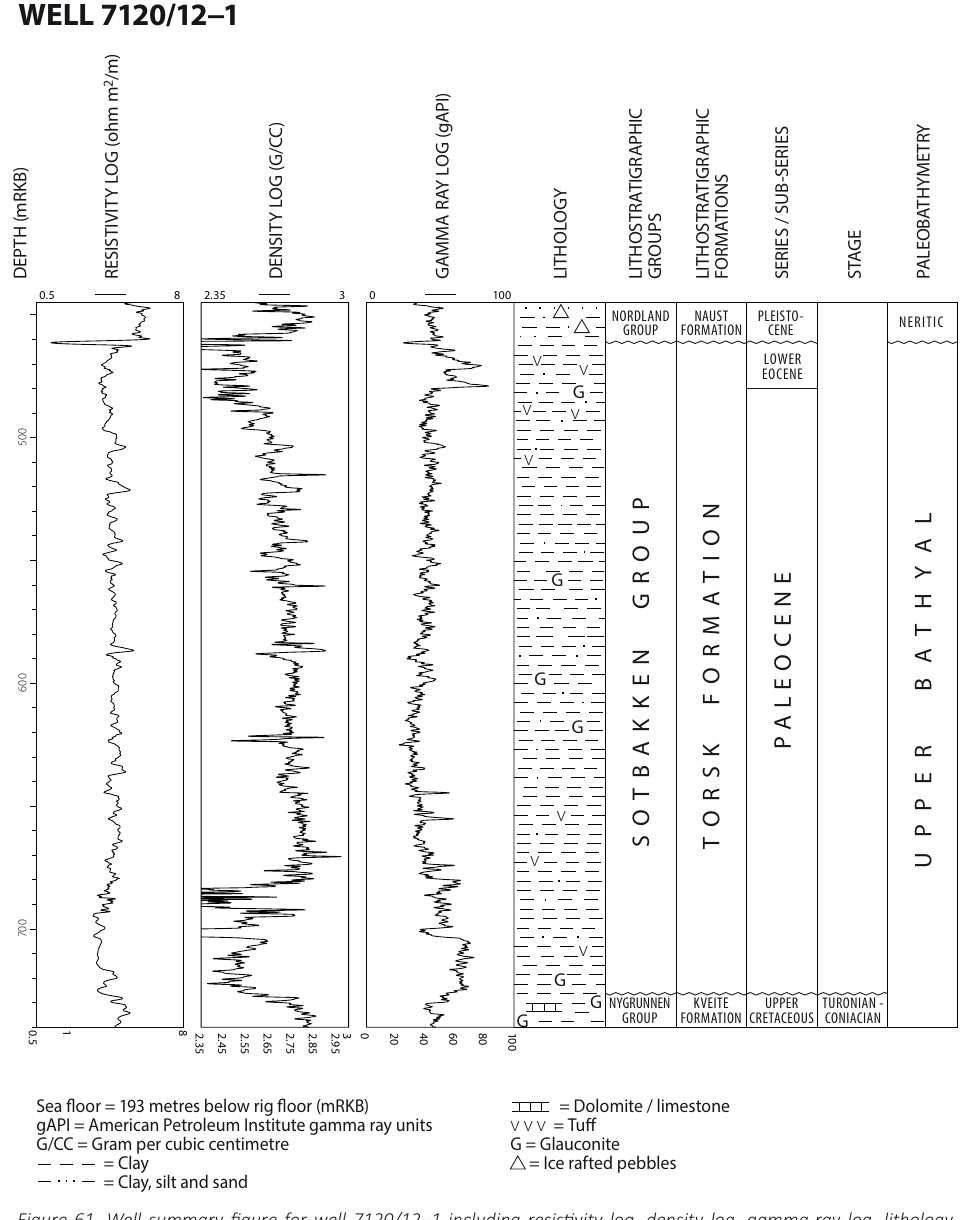
Figure 61. Well summary figure for well 7120/12–1 including resistivity log, density log, gamma-ray log, lithology, lithostratigraphic units, series/sub-series, stage and paleobathymertry for the well reference section of the Torsk Formation (Turonian–Coniacian to Pleistocene; from